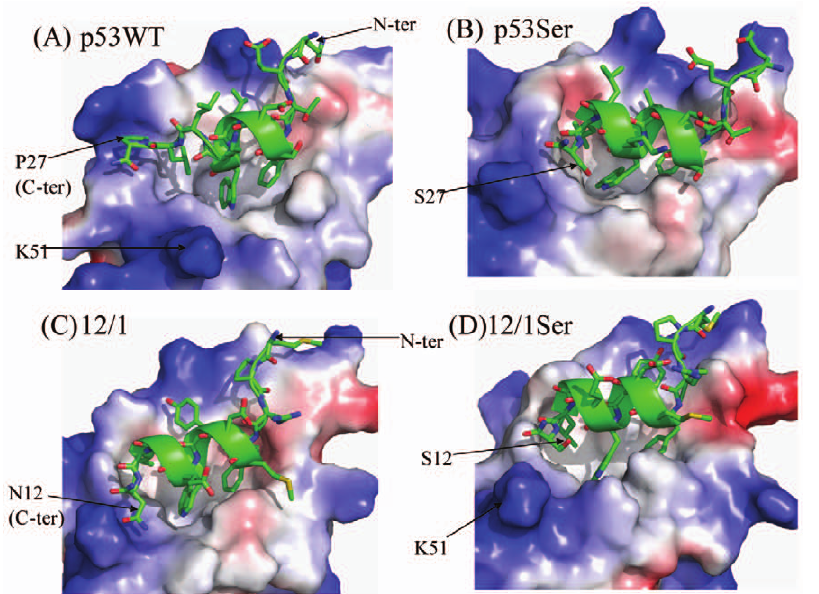
Figure 3. Representative snapshots depicting helix formation in the MDM2 interacting derivative peptides and their packing against the surface of MDM2. Representative snapshots to show that non-Proline substitution at the C-terminal end of the ligand promotes helix formation. Also shown is that the bulkier Asn side chain is accommodated differently compared to a smaller side chain like Ser when the peptide is in a helical conformation. The positively and negatively charged regions on the MDM2 surface have been shown with blue and red colors respectively.